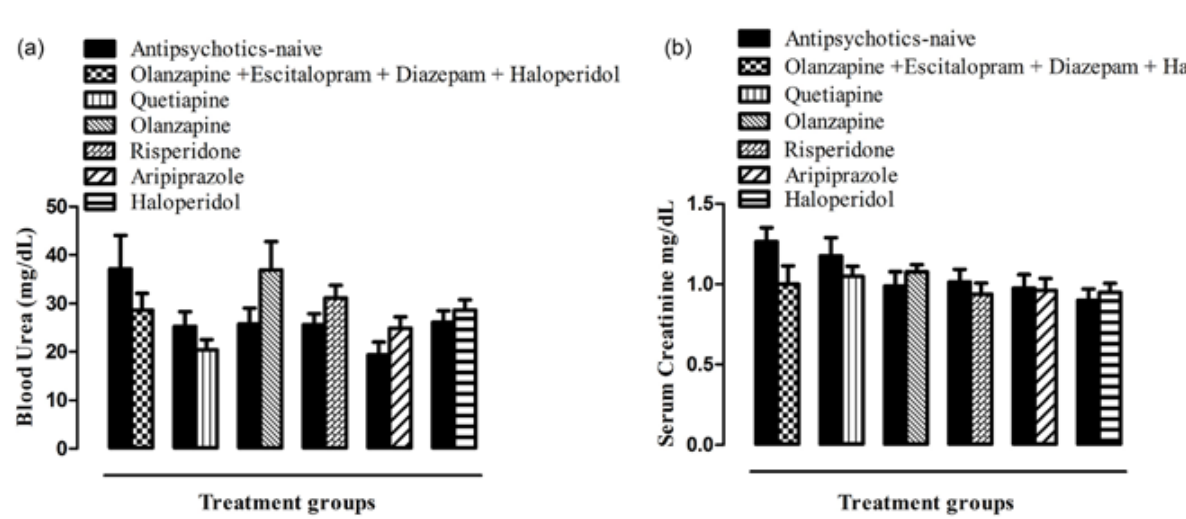
FIGURE 10 - Effect of selected antipsychotics on blood urea (a) and serum creatinine (b): Antipsychotic-naïve patients were treated with olanzapine in combination with escitalopram, diazepam (STAT, I.V) and haloperidol (STAT, I.M) (OLEDH, n=8), or quetiapine (QUET, n=8), olanzapine (OLAN, n=8), risperidone (RISP, n=8), aripiprazole (n=8) or haloperidol (n=8) in therapeutic doses for an average time period of 39, 40, 45, 38, 30 and 33 days respectively showing no significant change in blood urea and serum creatinine as compared to antipsychotics-naïve patients (*P < 0.05) (ANOVA followed by Bonferroni’s Multiple Comparison